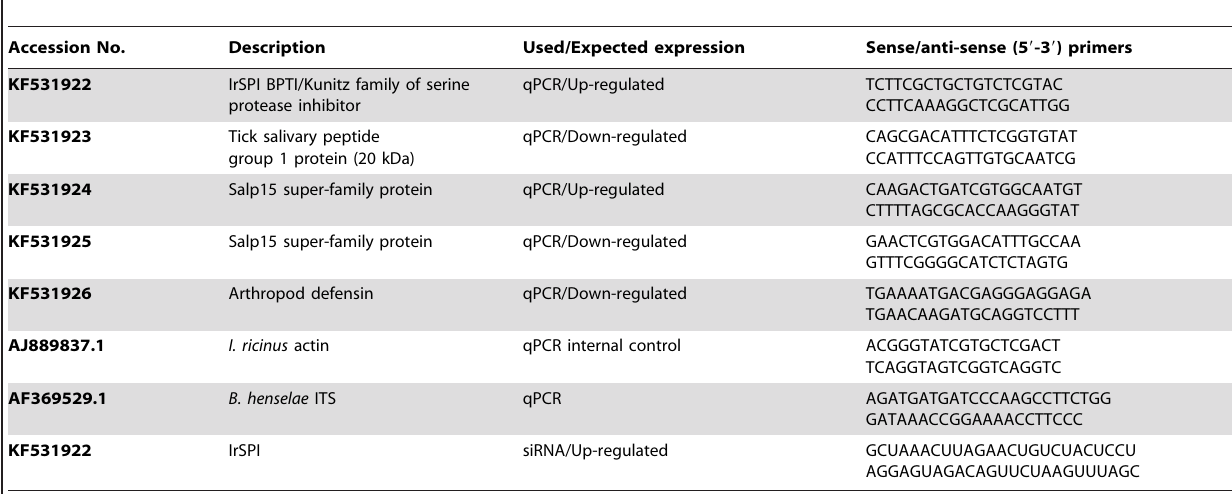
Table 1. List of qPCR primers and siRNA sequences used in this article, and the accession number of the corresponding I. ricinus gene.